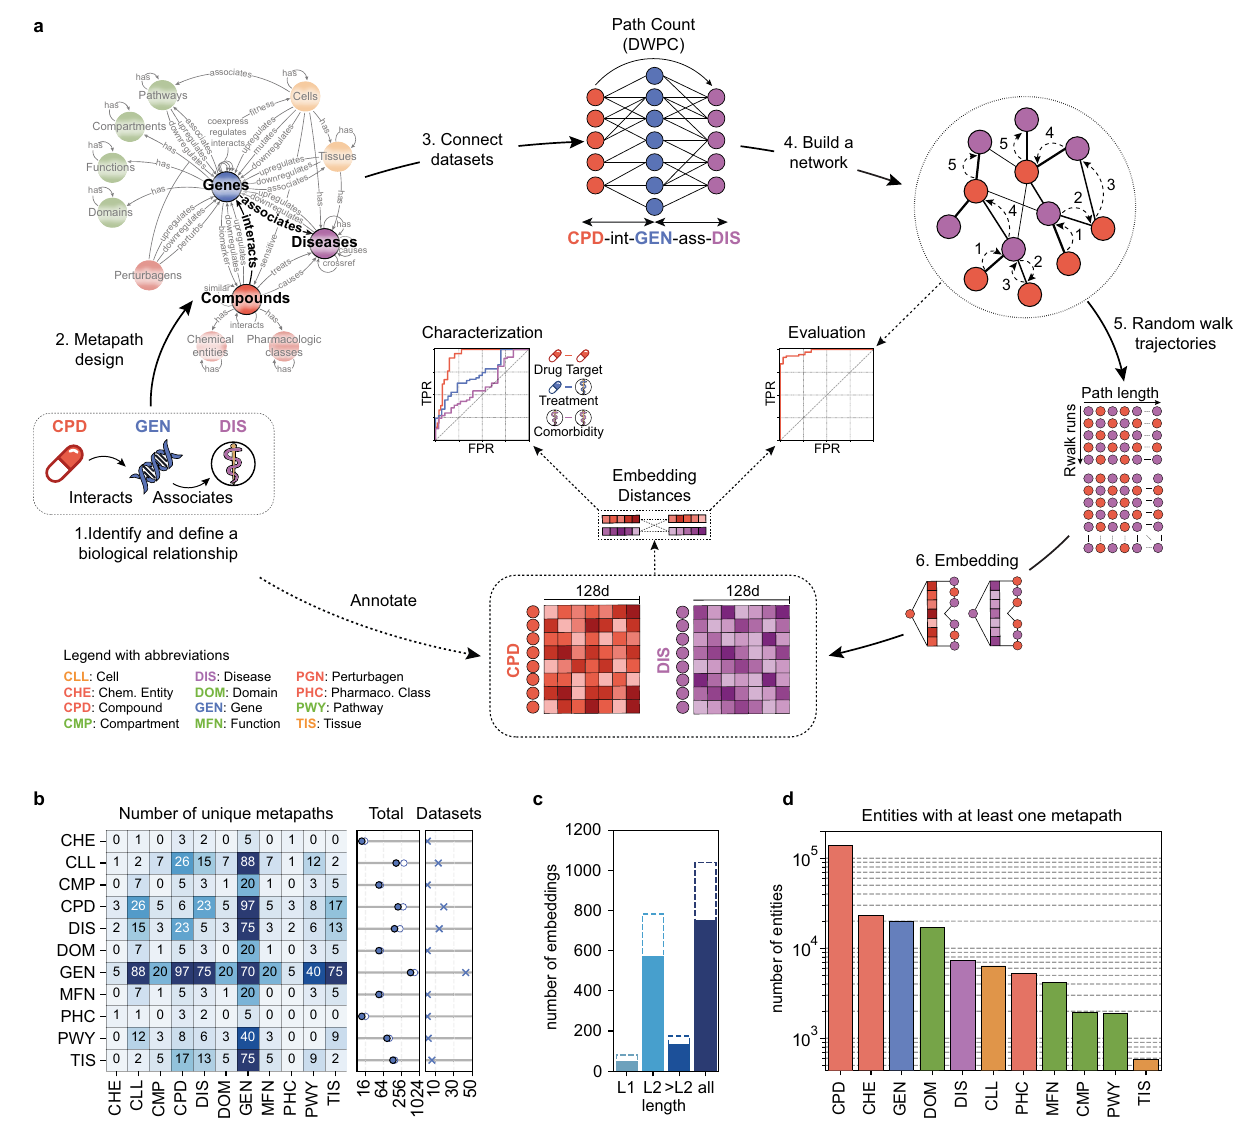
Fig.2|GeneratingtheBiotequeembeddings.a Schemeofthemethodology.First, we de fi ne the biological entities to be connected and the speci fi c context to be explored. Then a source-target network is derived by traversing all the paths avail- able from the source to the target nodes of a given metapath. The vicinity of each node in the network is then explored by a random walker and embedded in a 128- dimensional space. Finally, embeddings are evaluated and characterized. b Number of unique metapath embeddings linking each entity. In the middle plot, the fi lled dots indicate the total number of unique metapaths while the empty dots show the